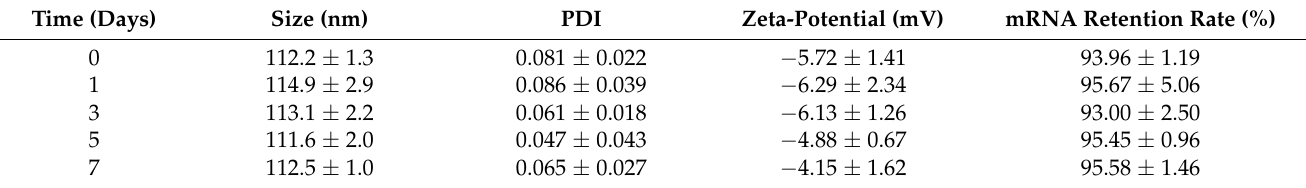
Table 1. The time-dependent physical stabilities of mRNA encapsulating